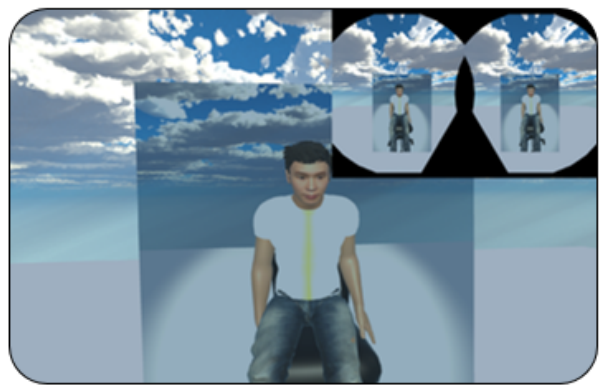
Figure 9. The VR interfaces.